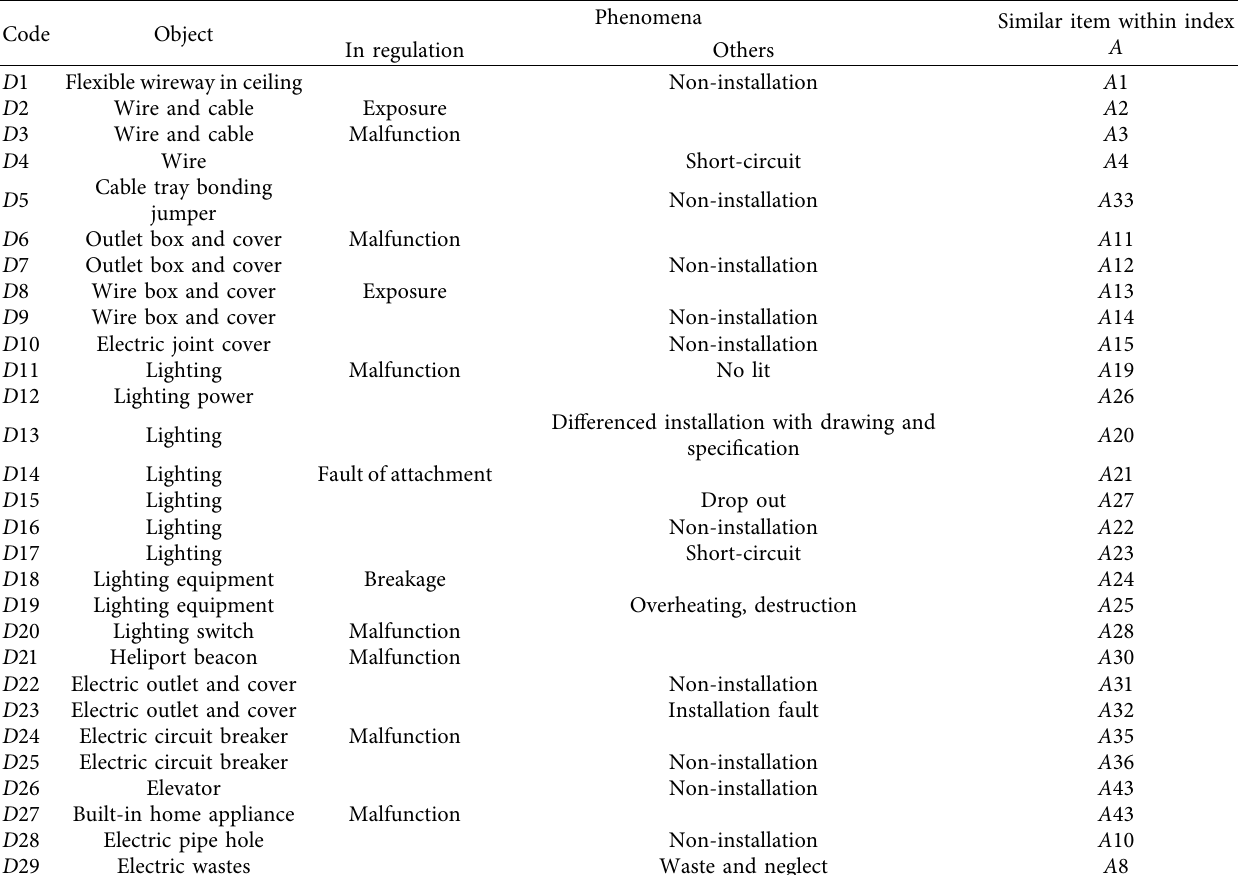
Table 1: Quality management item of index D